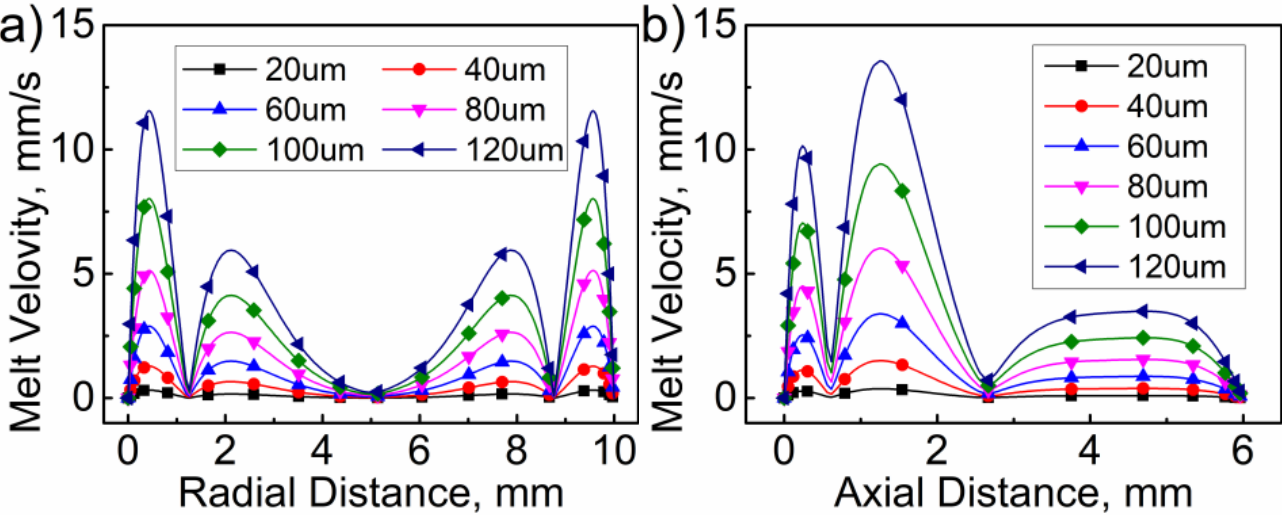
Figure 9. Influence of ultrasonic amplitude on the melt stream velocity in ( a ) radial and ( b ) axial directions.